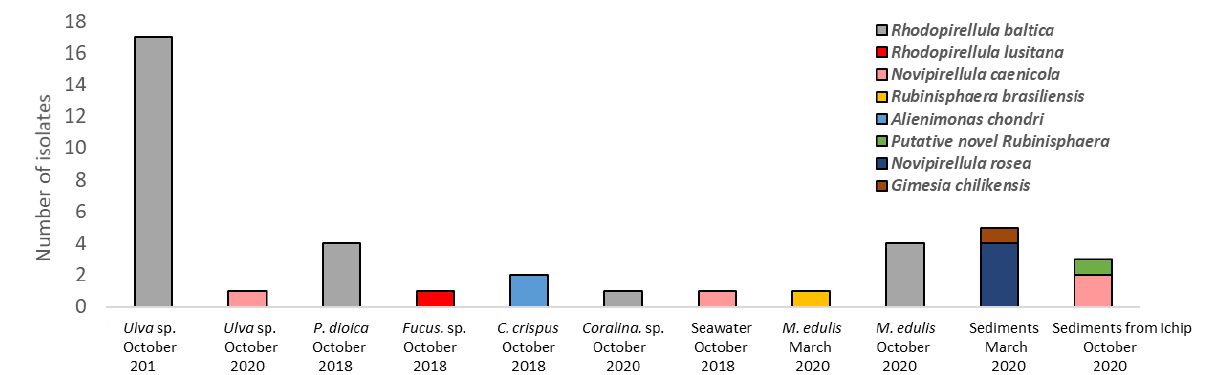
Figure 2. Number of isolates obtained from the different samples and collection dates. The different colors are indicative of the phylogenetic affiliation of the isolates.